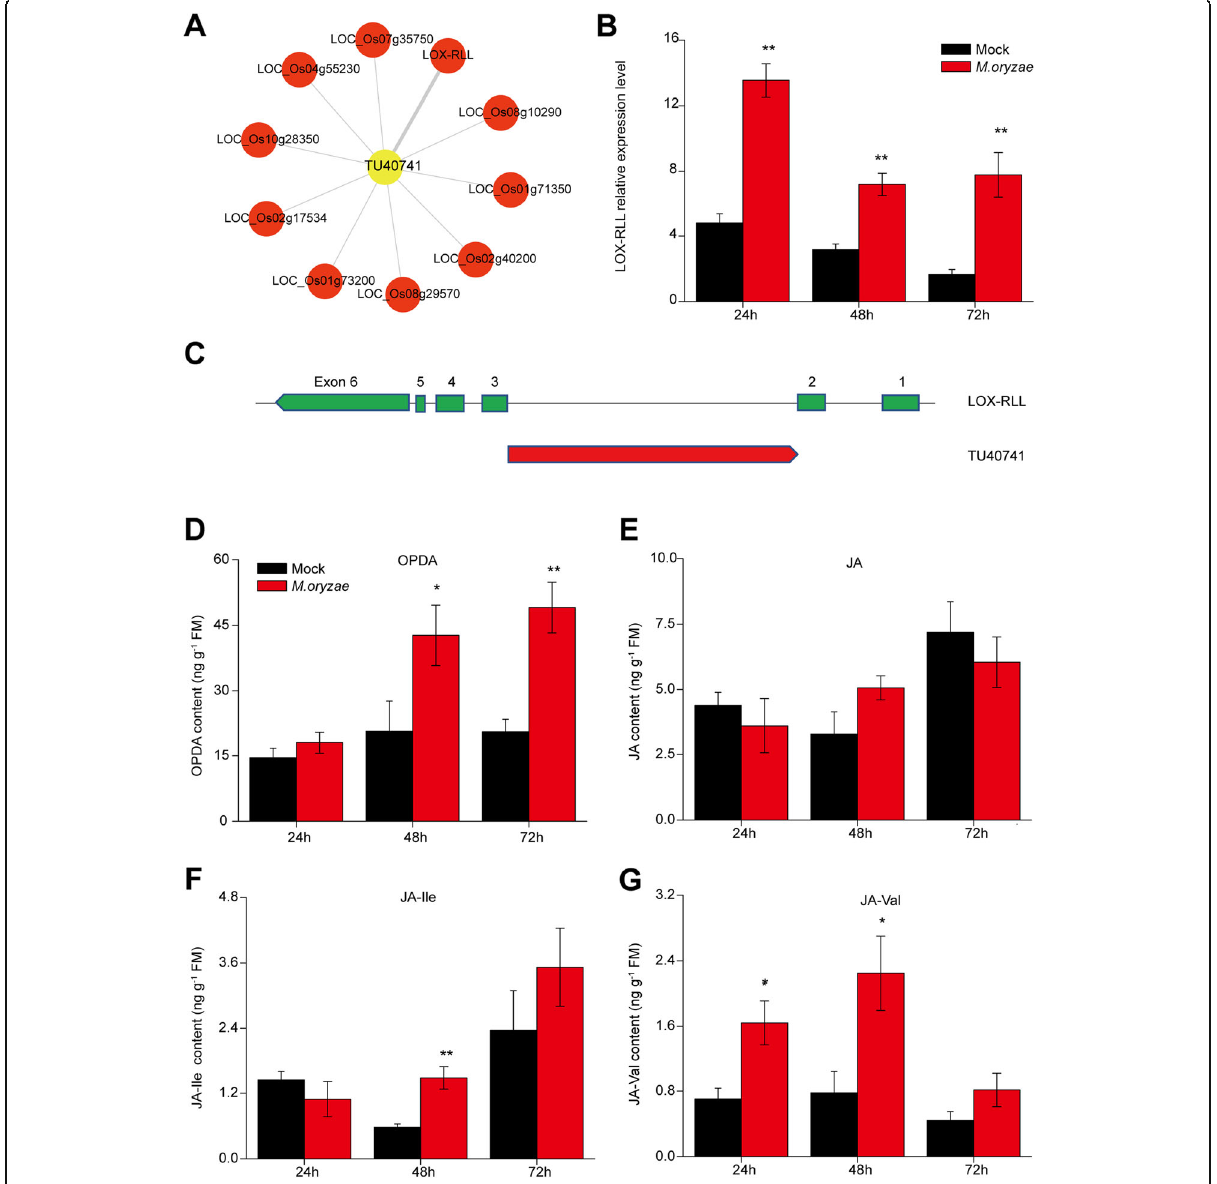
Fig. 5 An intronic RNA is derived from jasmonate biosynthetic gene. a Network plot of correlation between a DE-IncRNA and co-expressed genes based on WGCNA analysis. LOX-RLL, herbivore induced lipoxygenase. b Mean transcriptional abundance (±SE, n = 5 – 8) of LOX-RLL in M. oryzae -treated samples and control samples. Asterisks indicate significant differences in M. oryzae -treated samples compared with control samples (**, P < 0.01; Student ’ s t test). c Schematic diagram of LOX-RLL and its intron-derived transcripts. The six exons of LOX-RLL were highlighted by green. The intronic RNA was derived between exon 2 and exon 3, which has a opposite direction compared with LOX-RLL transcripts. Mean levels (±SE, n = 5 – 8) of OPDA ( d ), JA ( e ), JA-Ile ( f ) and JA-Val ( g ) in M. oryzae -treated samples and control samples. Asterisks indicate significant differences in M. oryzae -treated samples compared with control samples (**, P < 0.01; Student ’ s t